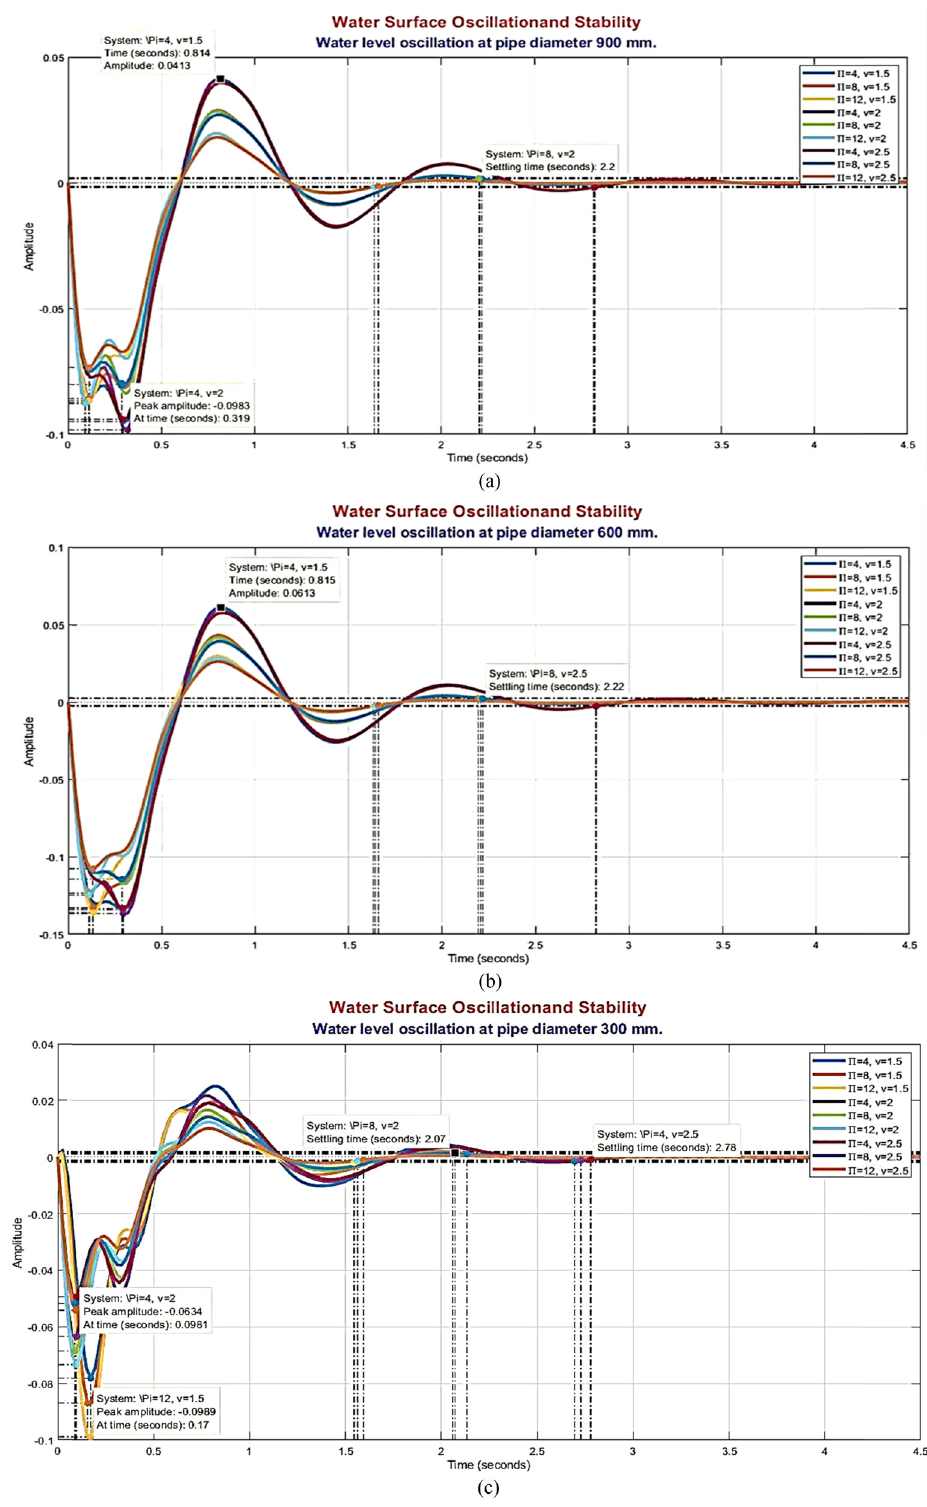
Figure 4: System stability with di ff erent pressure and fl ow rate e ff ects, for water fl uid types with di ff erent pipe diameters. ( a ) Pipe diameter 900 mm. ( b ) Pipe diameter 600 mm. ( c ) Pipe diameter 900